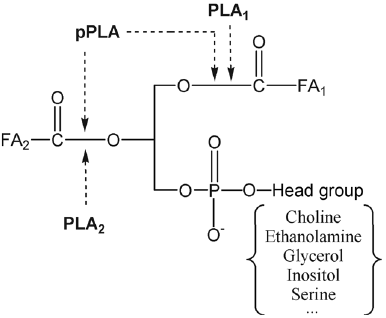
Figure 1 Positional specificity of plant phospholipase As (PLAs) on phospholipids. FA, fatty acyl chain; pPLA, patatin-like PLA. Some plant PLAs can also use glycolipids, lysophospholipids, and neutral glycerolipids as substrates (Table